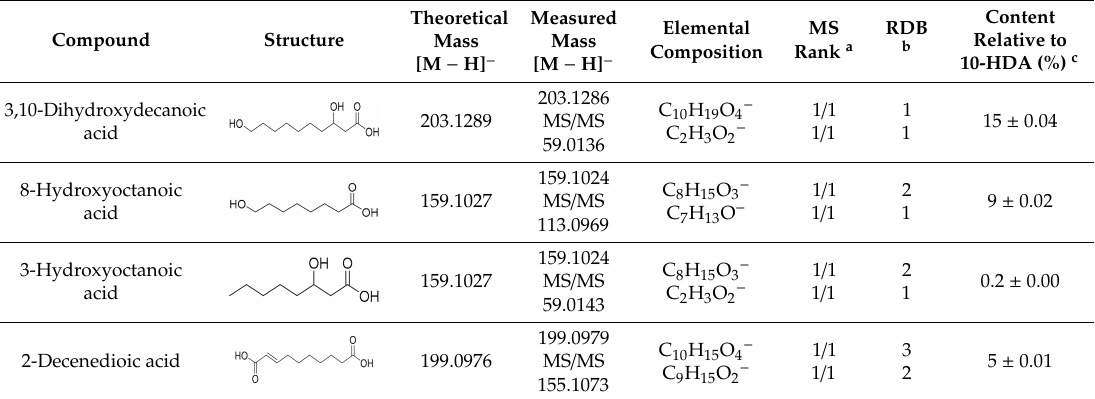
Table 4. Suspect analysis